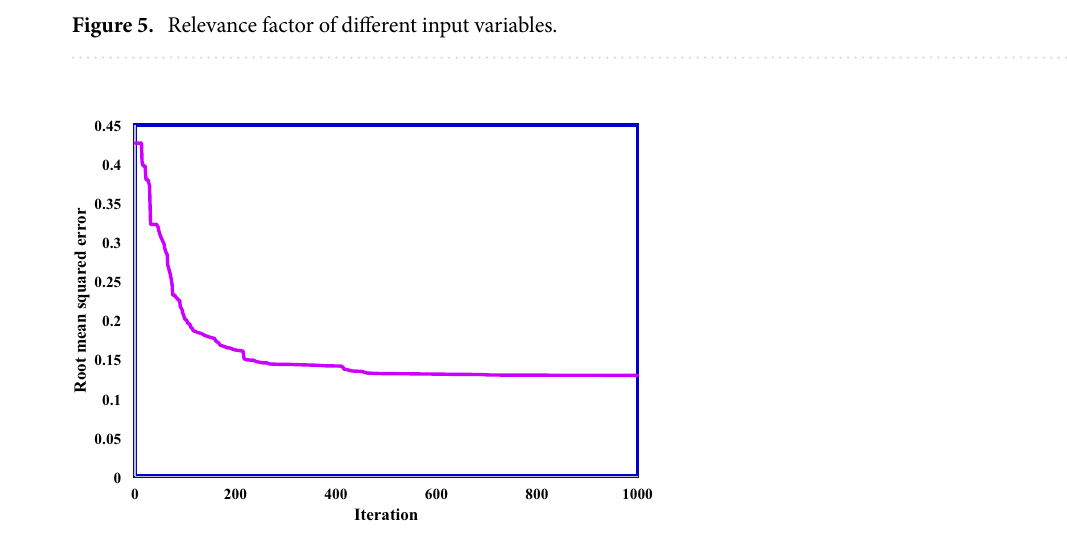
Figure 6. Performance of GWO approach to optimize ANFIS